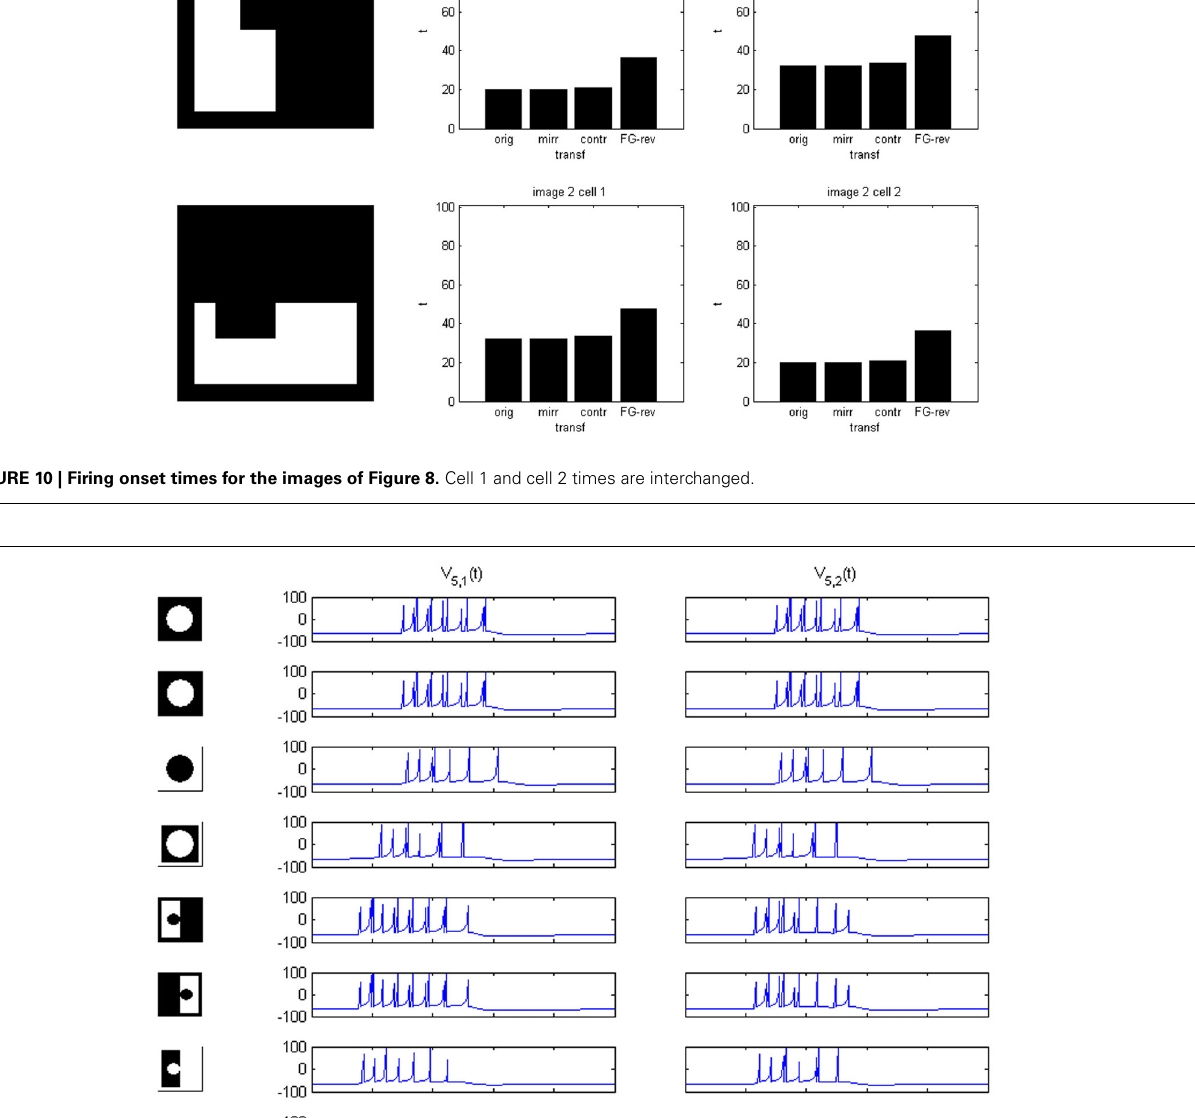
the “ F = 1” channel signals). Indeed the spike counts shown